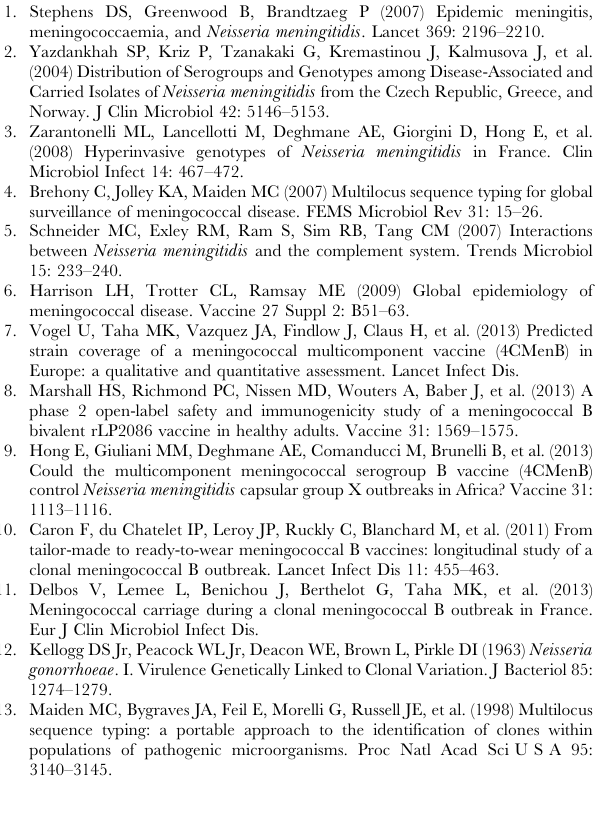
Table S1 Characteristics of carriage isolates of N. meningitidis . Phenotypic and genotypic typing data